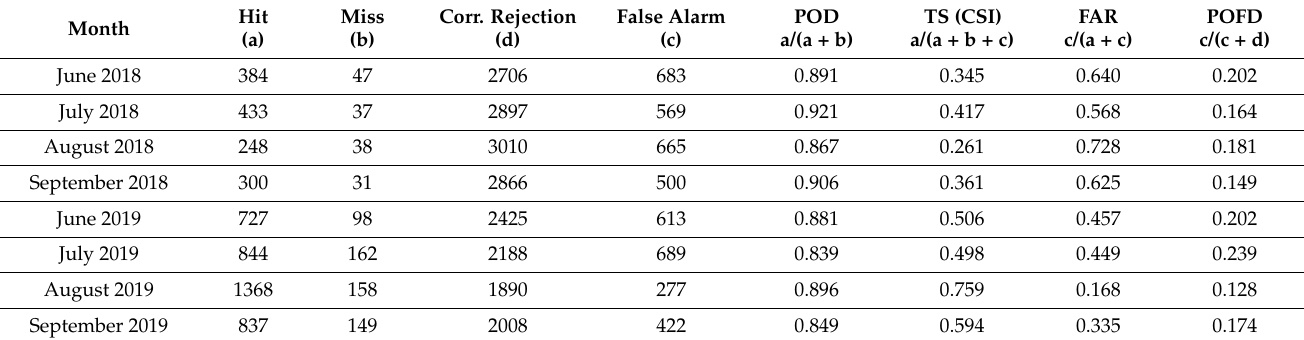
Table 3. Statistical validation using POD, TS (CSI), FAR, POFD for the period 2018–2019.